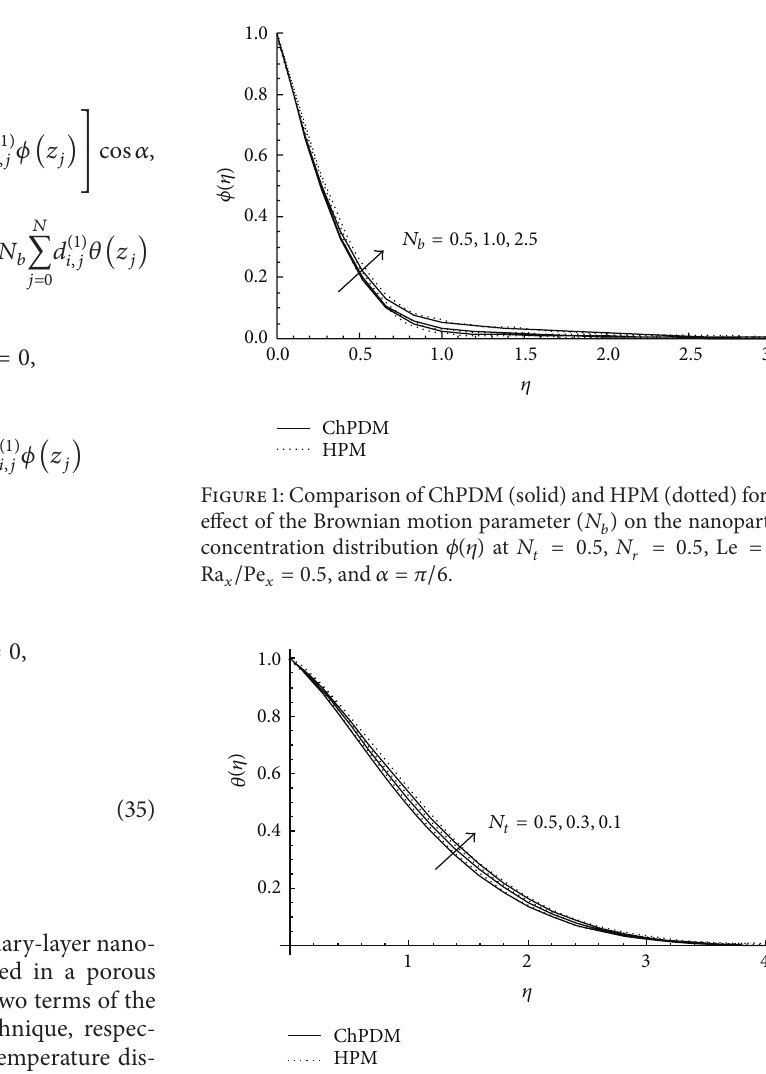
Figure 2: Comparison of ChPDM (solid) and HPM (dotted) for the effect of the thermophoretic parameter (𝑁 𝑡 ) on the temperature distribution 𝜃(𝜂) at 𝑁 𝑏 = 0.5 , 𝑁 𝑟 = 0.5 , Le = 10 , Ra 𝑥 / Pe 𝑥 = 0.5 , and 𝛼 = 𝜋/6